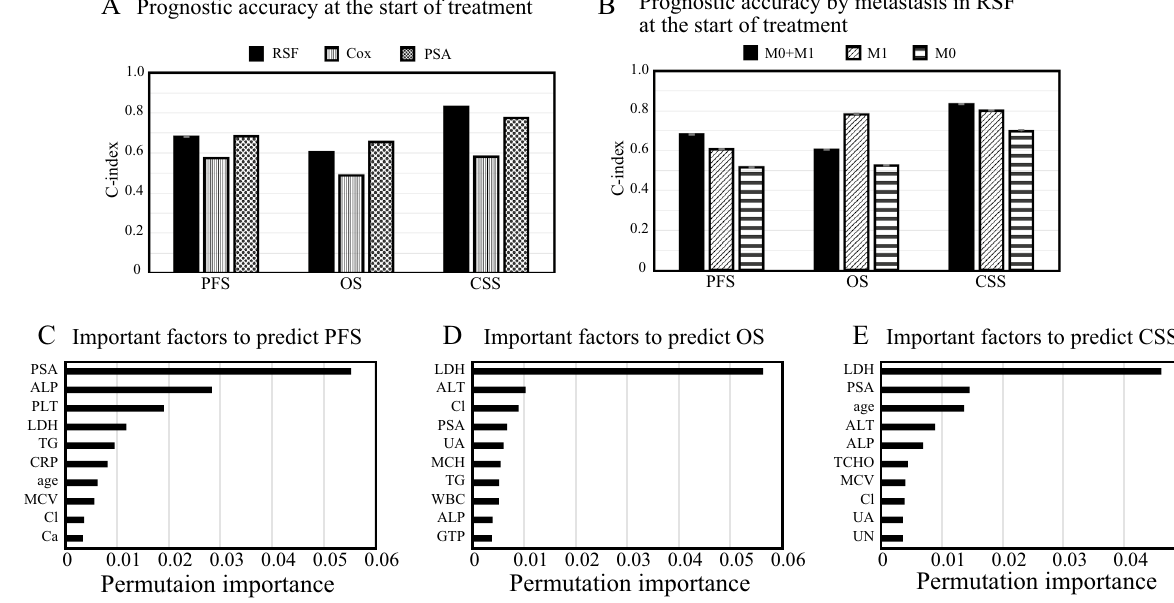
Figure 1. Comparison of accuracy of prognostic prediction models. ( A ) Comparison of C-index for each prognostic prediction model. Black, shaded, and horizontal bars indicate RSF, Cox proportional hazards, and PSA models, respectively. ( B ) Comparison of C-index for application of RSF model to patients with metastatic and non-metastatic prostate cancer. Black, striped, and dotted bars indicate all patients with prostate cancer, patients with metastatic prostate cancer, and patients with non-metastatic prostate cancer, respectively. ( C to E ) Permutation importance in prediction of progression ( C ), overall survival ( D ), and cancer specific survival ( E ) based on the RSF